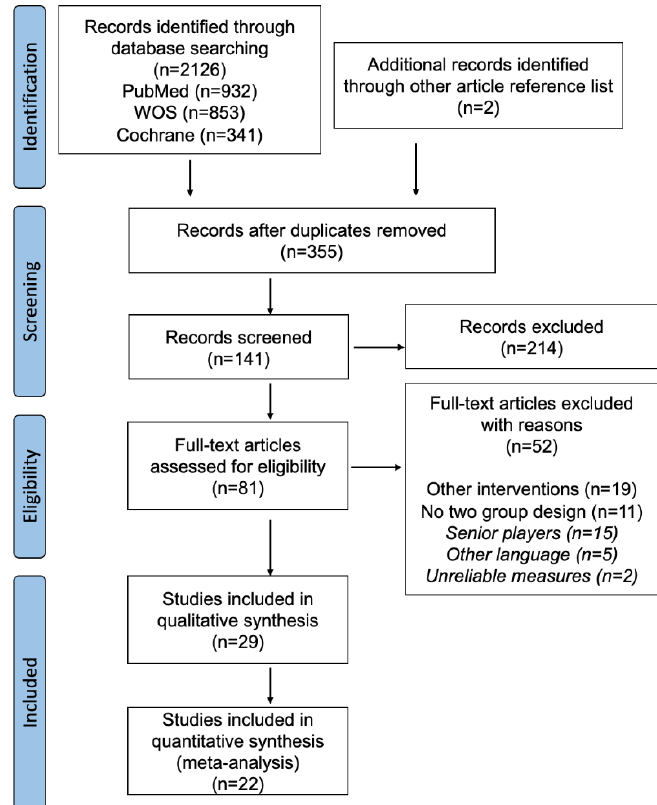
Figure 2. Flow diagram of study selection in PRISMA ® 35.